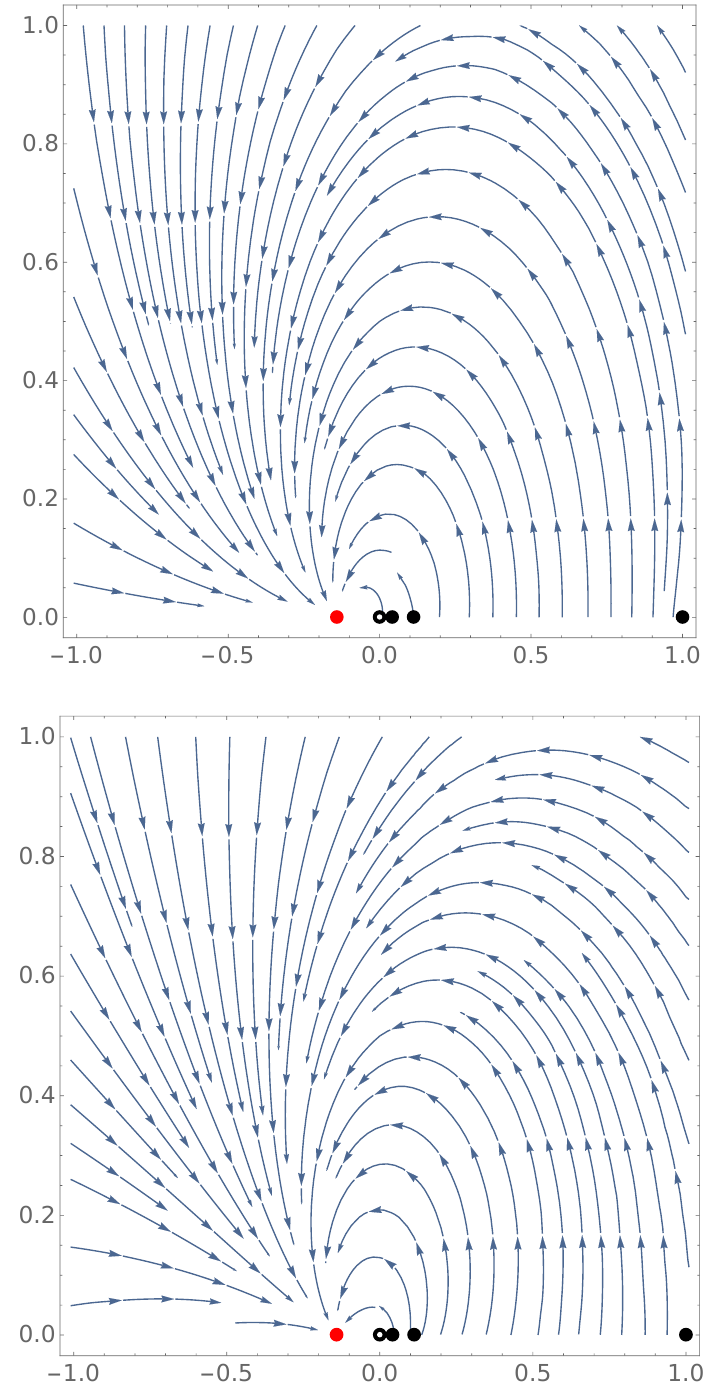
Figure 4 . The (cid:13)ows for ’ = ’ ( (cid:26) ) for the charges Q = (0 ; 0 ; 2 ; 1) T (above) and Q = ( (cid:0) 4 ; 15 ; 5 ; 0) T (below) leading to attractor point at ’ = (cid:0) 1 = 7. The point of maximal unipotent monodromy at ’ = 0 is indicated by a hollow black dot while the solid black dots represent conifold singularities.